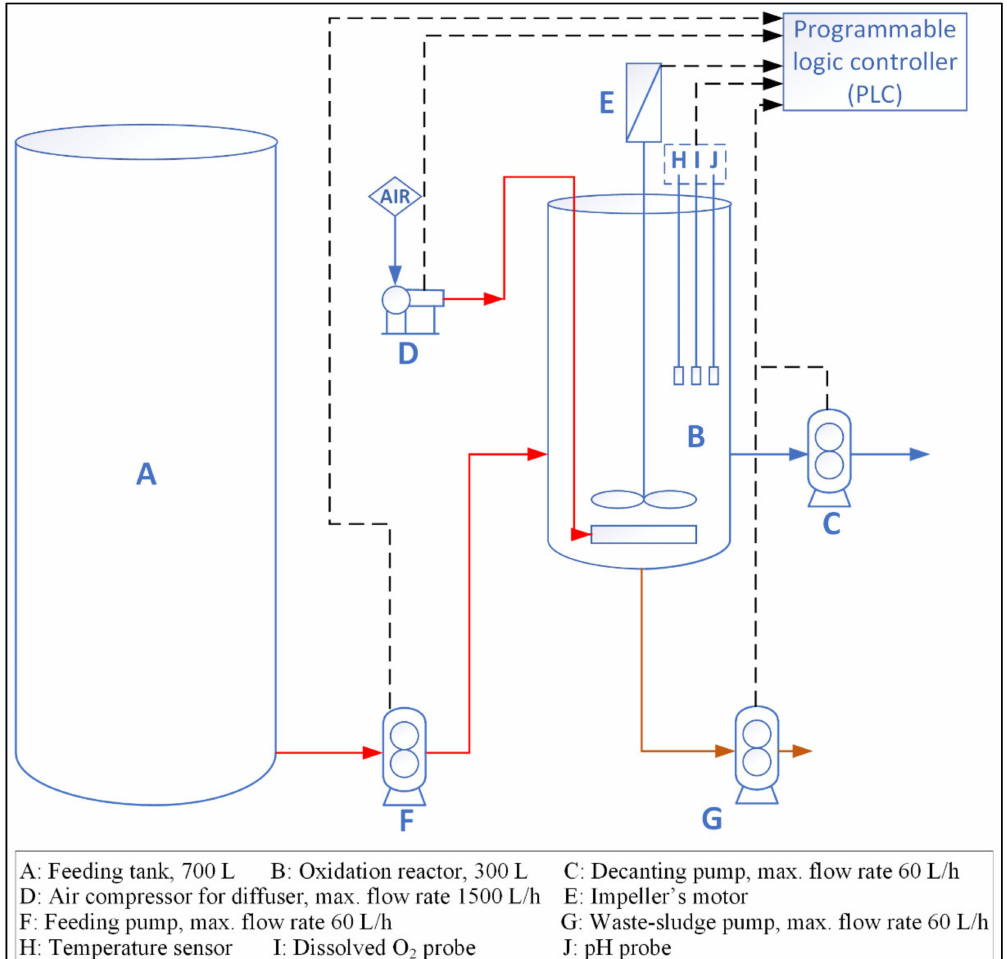
Figure 1. Schematic diagram of the pilot-scale sequencing batch reactor